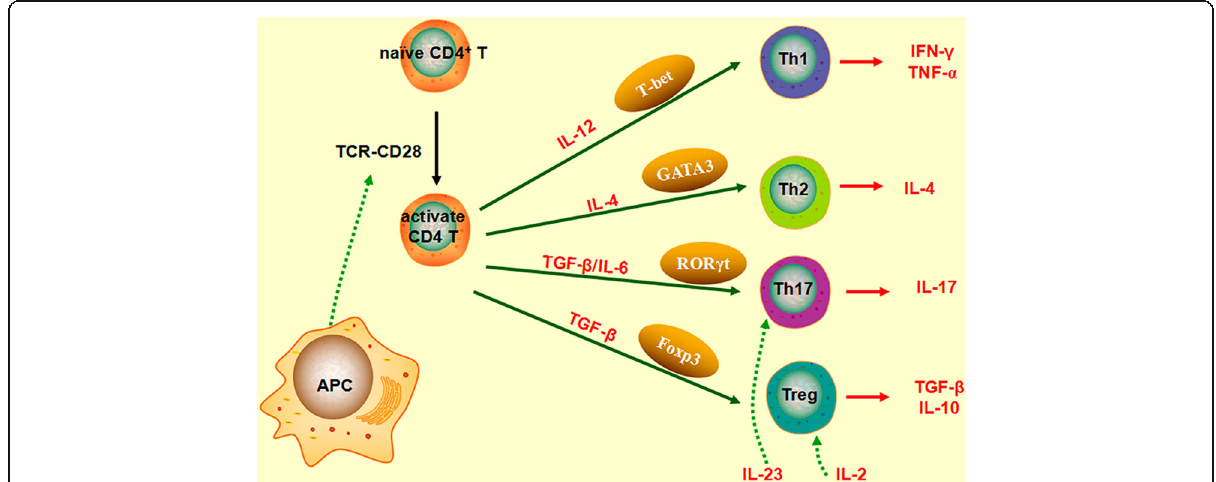
Fig. 7 Differentiation of naïve CD4 T cells differentiate into Th (including Th 17) and Treg subsets (designed by using